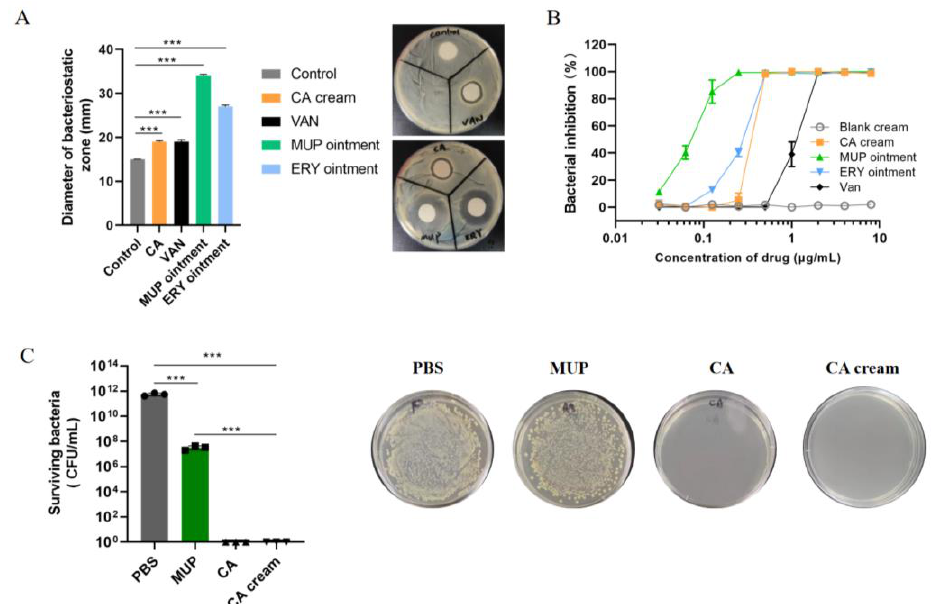
Figure 5. In vitro antibacterial activity of chrysomycin A cream. ( A ) Kindy–Bauer method. Methanol extract of each formulation was added to a circular filter paper with a diameter of 15 mm. The filter papers were placed on TSA plate to observe inhibition zones. ( B ) CA cream exhibits a similar ability to ERY ointment to reduce bacteria survival. The MIC of different formulations was determined by detecting the bacteria survival. ( C ) MRSA (OD 600 = 0.5) was treated with CA formulations to further test the anti-MRSA activity of CA and CA cream, MUP was used as positive control. CA and CA cream treatment resulted in the eradication of living cells to the limit of detection. Statistical analysis was expressed as the mean ± SD, using a one-way ANOVA or Student’s t -test. The data were considered as statistically significant difference when *** p < 0.001 versus the indicated group.